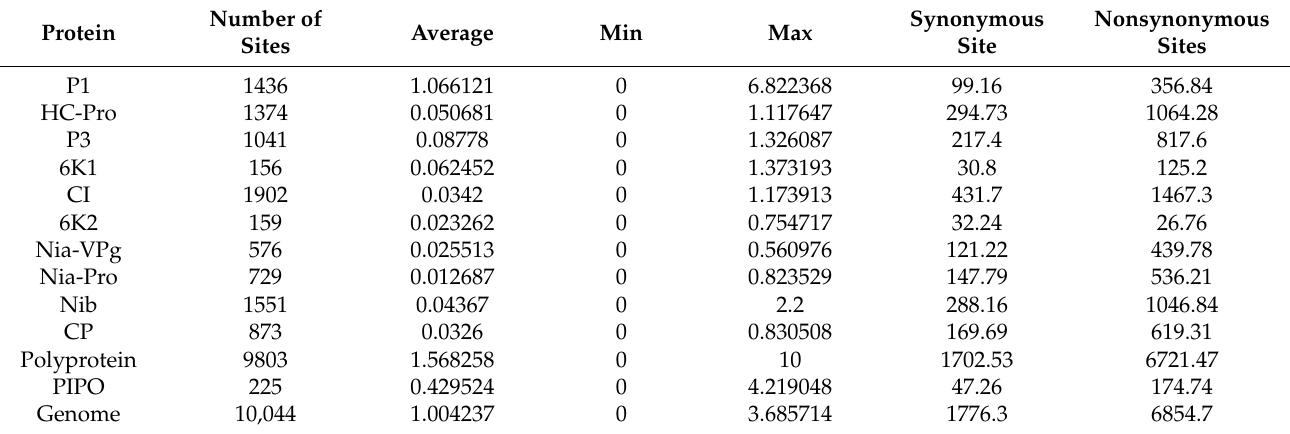
Table 2. Summary of synonymous site and nonsynonymous sites for individual SMV protein sequences.